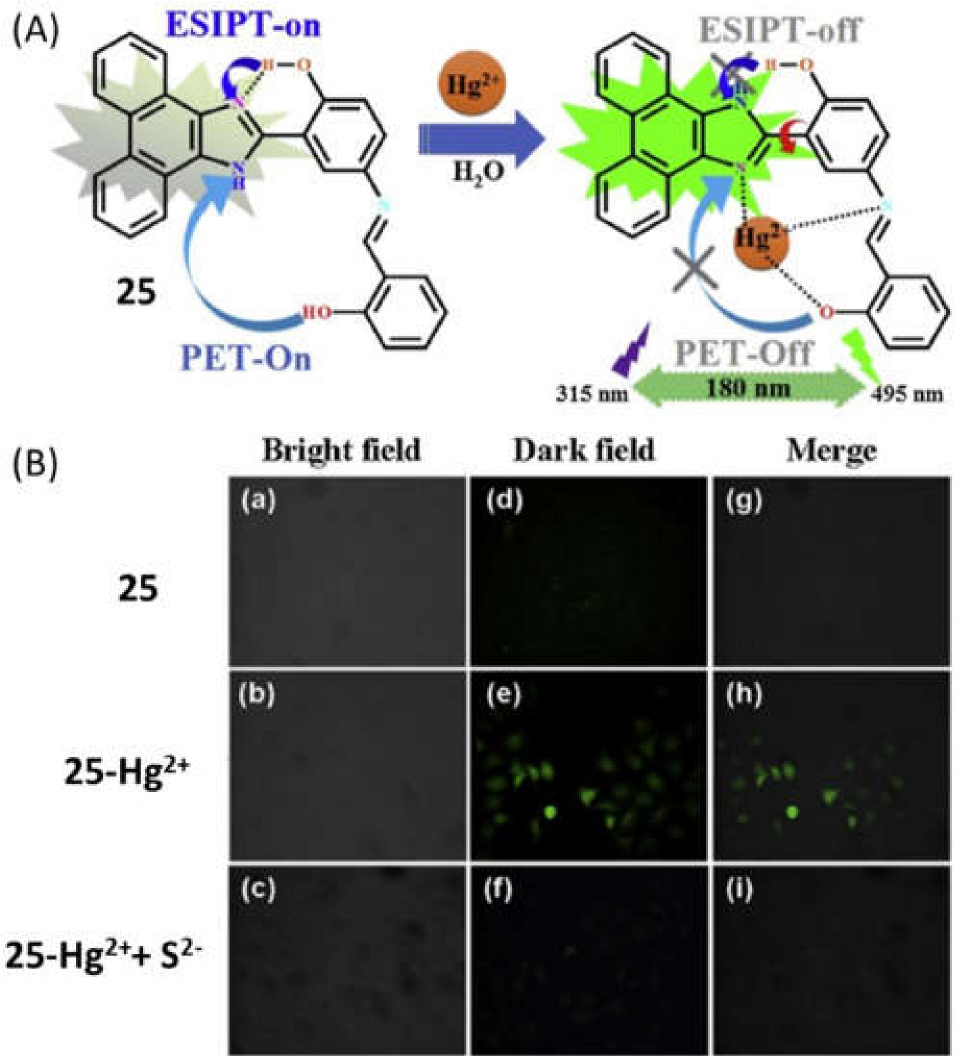
Figure 10. ( A ) Proposed binding mode and responding mechanism of 25 with Hg 2+ . ( B ) Confocal fluorescence images of HeLa cells incubated by 25 ( a , d , and g ), 25 -Hg 2+ ( b , e , and h ) and 25 -Hg 2+ + S 2 − ( c , f , and i ), respectively. Reproduced with permission from [56]. Copyright 2020